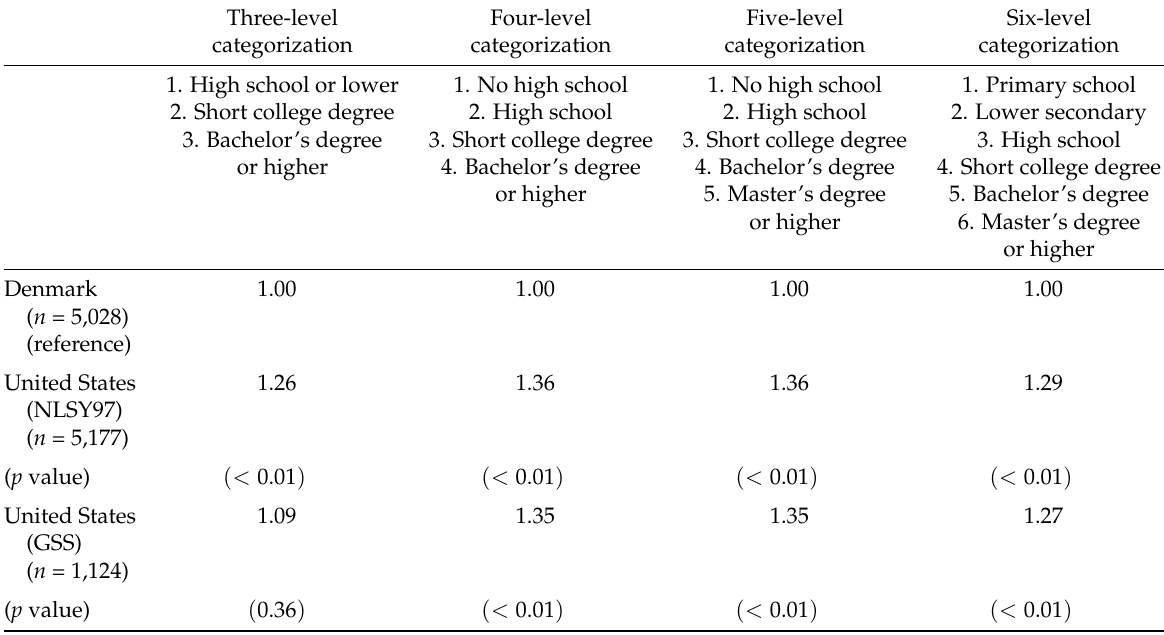
Table 4: Unidiff model parameters (phi): different levels of educational aggregation